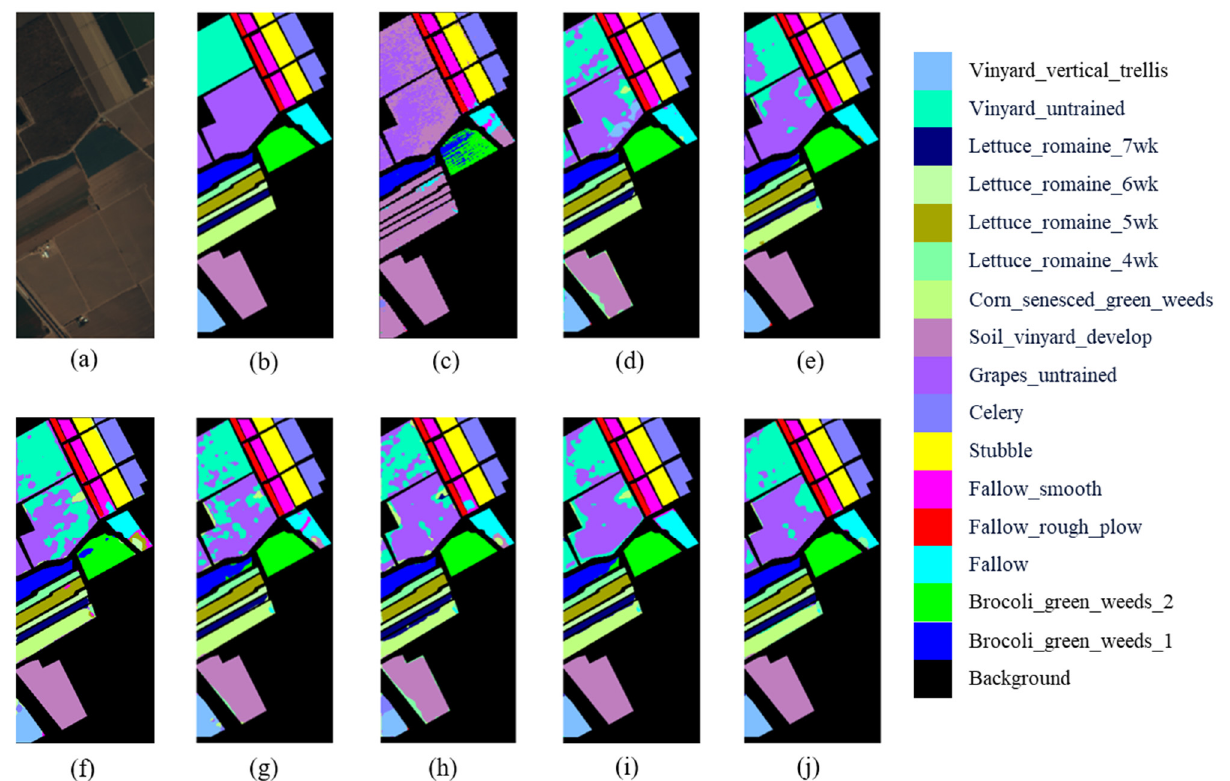
Remote Sens. 2023 , 15 , x FOR PEER REVIEW Figure 15. Classification maps of various HSI classification methods on the SV dataset. ( a ) False-Color maps. ( b ) Ground Truth. ( c – j ) SVM, SSRN, RSAKGN, DFSL + NN, DFSL + SVM, DCFSL, FSL-EGNN, and GDAFSL, respectively.